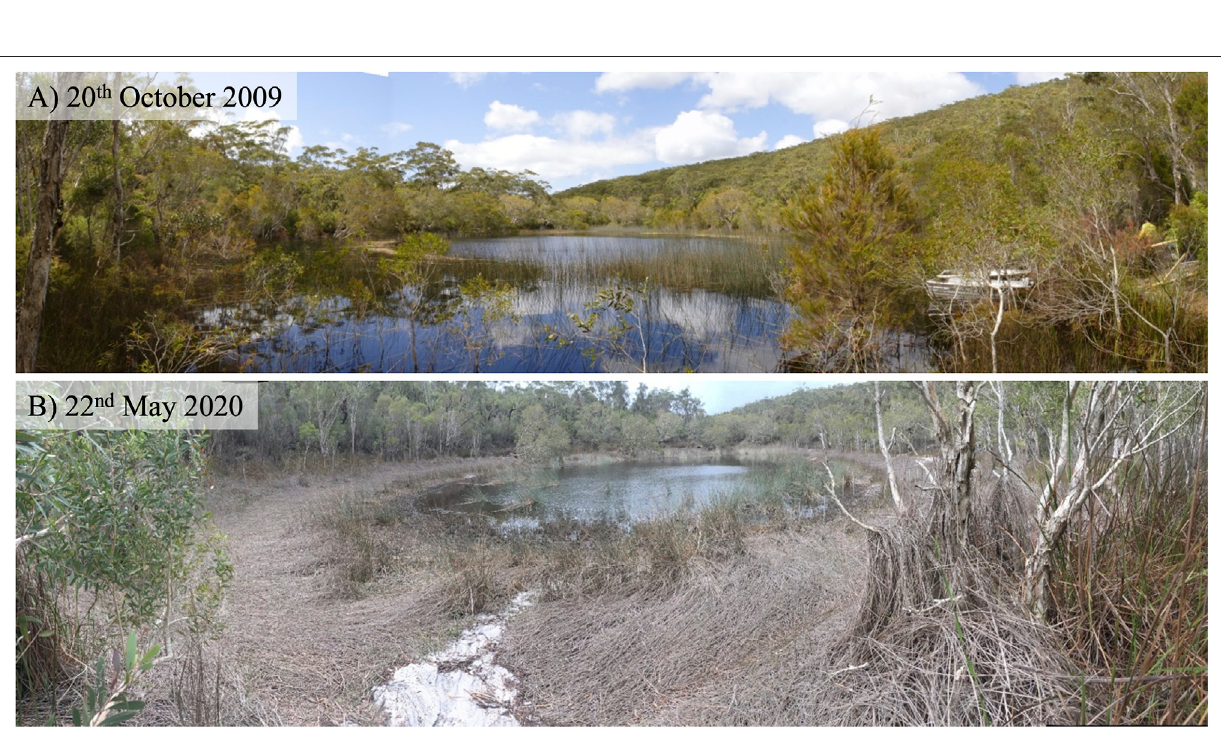
Frontiers in Environmental Science |